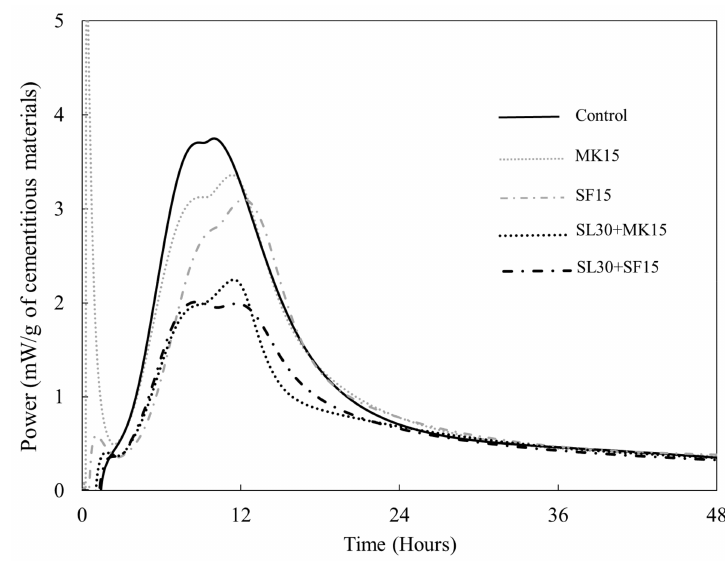
Figure 3. Rate of heat flow of 363 group mixtures.